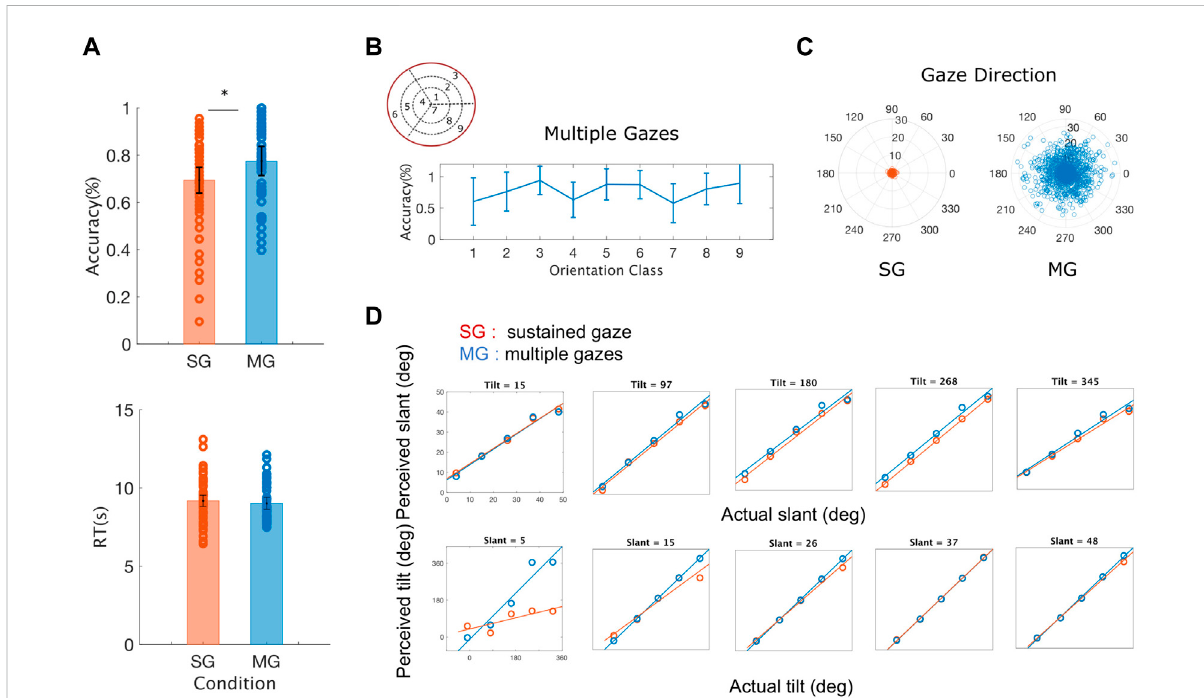
FIGURE 6 Averaged behavioral results across all the rotation pairs (slant and tilt) and all the participants (A) Average accuracy and average reaction time (RT) for sustained gaze fi xation (SG) and multiple gaze (MG) conditions. Each circle represents each participant ’ s accuracy for each of the nine orientationclassesandtheblacklinesdenotethestandarderrorofthemean(SEM) (B) AverageaccuracyfortheMultipleGazesconditionforeachof the nine orientation classes. The blue lines denote the standard error of the mean (SEM) (C) Gaze directions across all participants and orientation classes plotted for the Single Gaze condition (left) and the Multiple Gaze condition (right). The polar plot ’ s angle denotes the gaze direction ’ sorientationwhereasitsradiusrepresentsthegazedirection ’ sdistancefromthecenterofthescreen (D) Estimatedslantandtiltorientation values as a function of the actual plane ’ s slant and tilt. During the sustained gaze condition (SG) and for small values of slant, participants tend to grossly misjudge the tilt values of the stimulus plane 3D